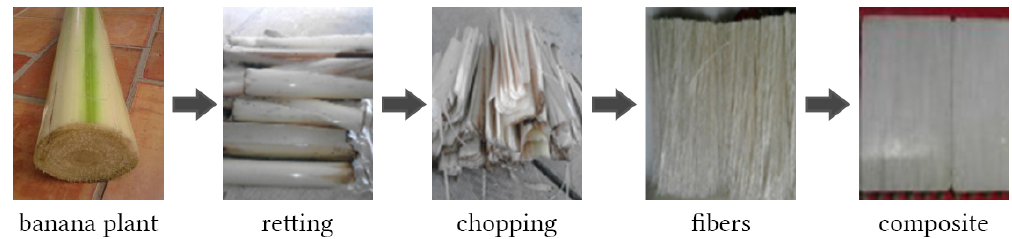
Figure 1. Extraction of fibers from the banana plant and the final composite laminate. Table 1. Manufacturing conditions of the analyzed specimens.